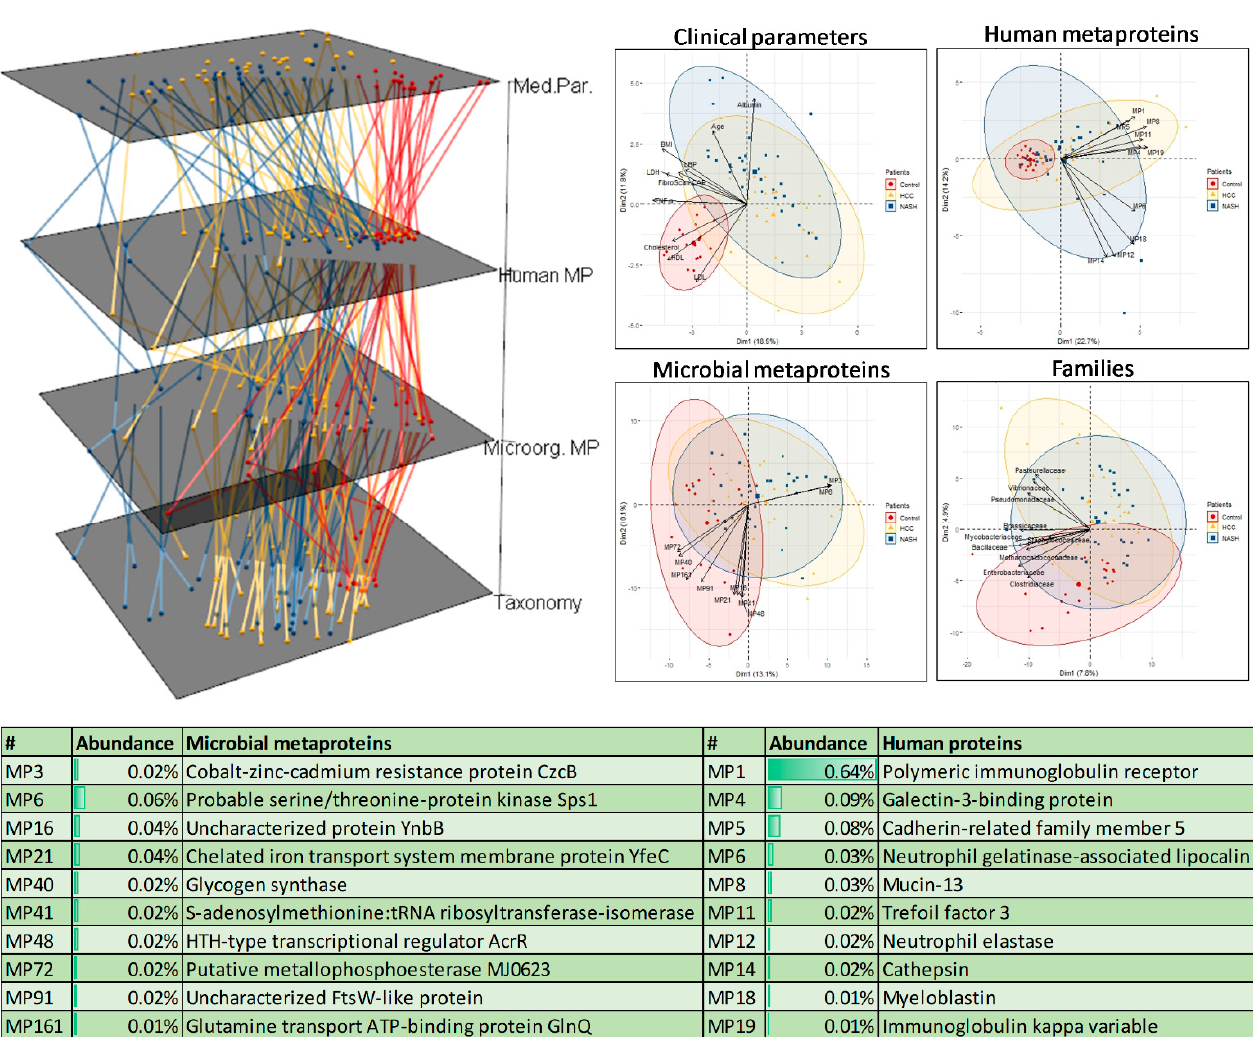
Figure 1. Multilayer PCA of clinical parameters, human and metaproteins, and family-level taxonomy for all samples. The individual PCAs were visualized on the left, and same samples were connected across all layers. The associated biplots with the top 10 loadings were shown on the right side. For human and microbial metaproteins, the metaproteins with at least 0.01% of the total spectral count were selected. In contrast, for families and clinical parameters, all 419 and 30 were chosen, respectively. For better readability, the top ten human and microbial loadings (metaproteins) were summarized in a table below the plot.